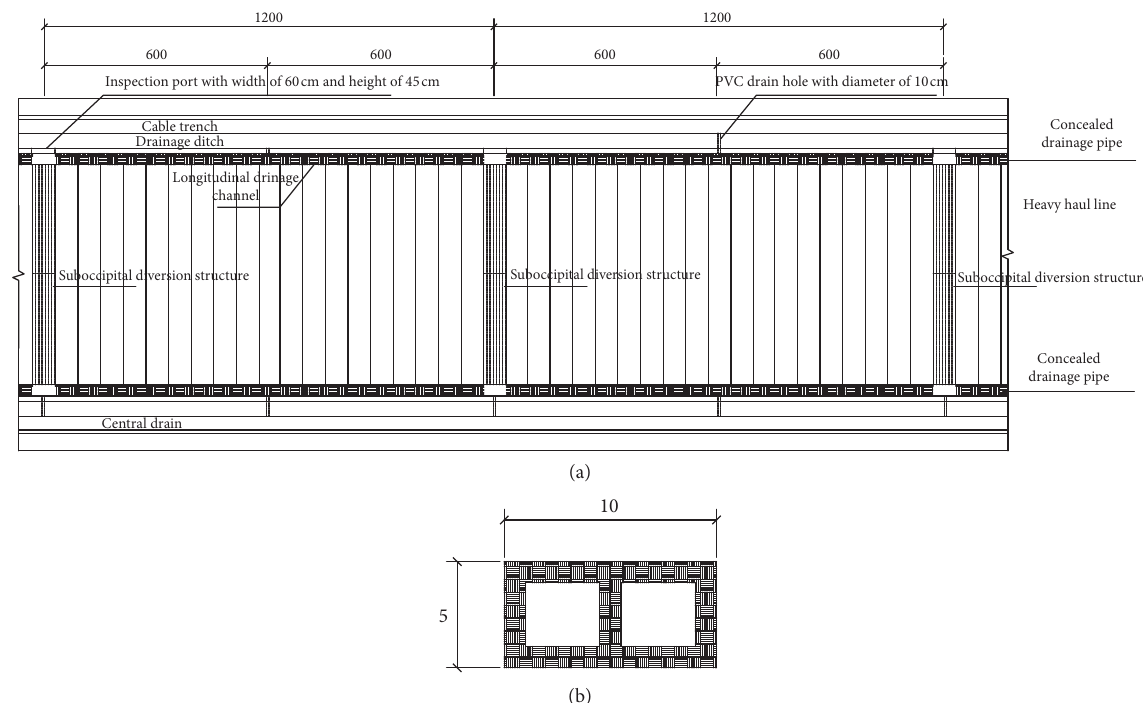
Figure 5: Design of drainage system at the bottom of tunnel. (a) Layout plan. (b) Cross section of longitudinal drainage pipe